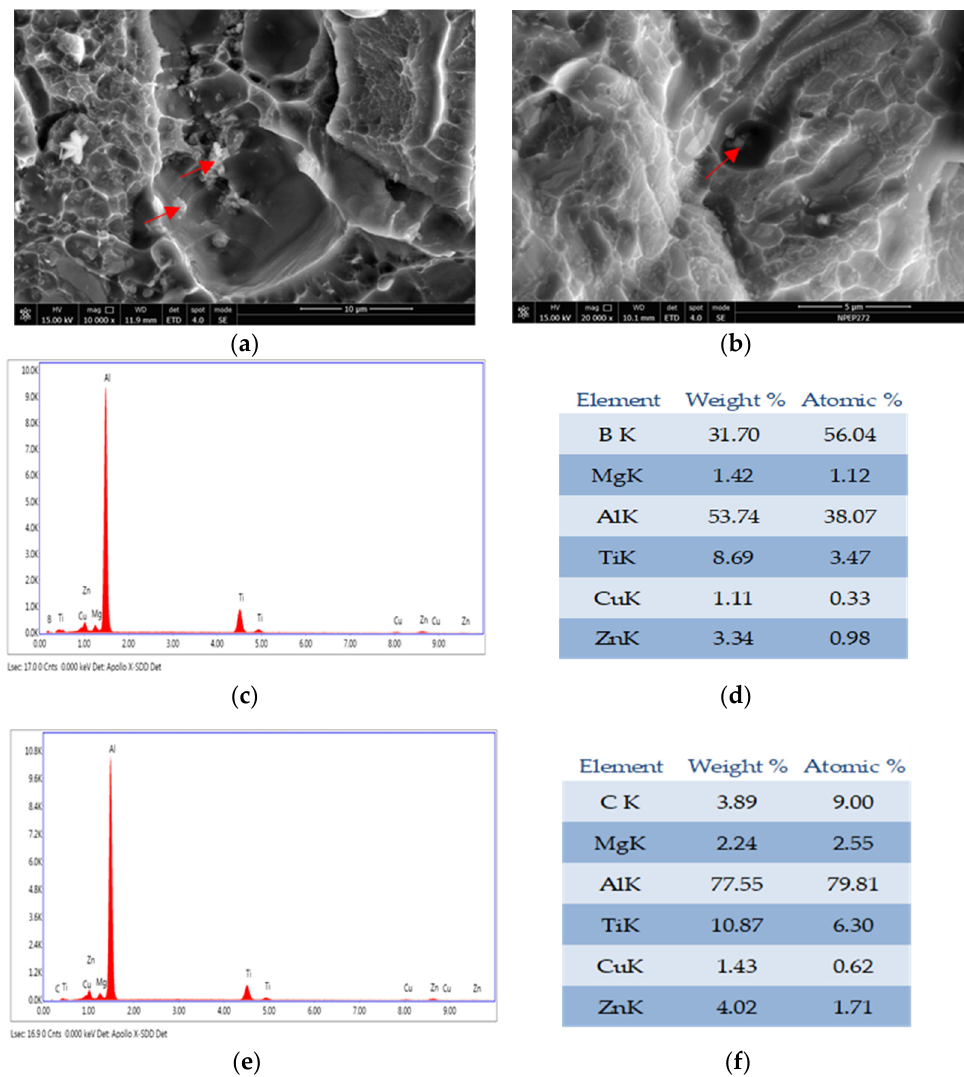
Figure 9. T-L Fracture surface for 7050 plate: ( a ) Al-5Ti-0.2B grain refiner, ( b ) Al-3Ti-0.15C grain refiner ( c , d ) EDS result of particles from ( a ), ( e , f ) EDS result of particles from ( b ).